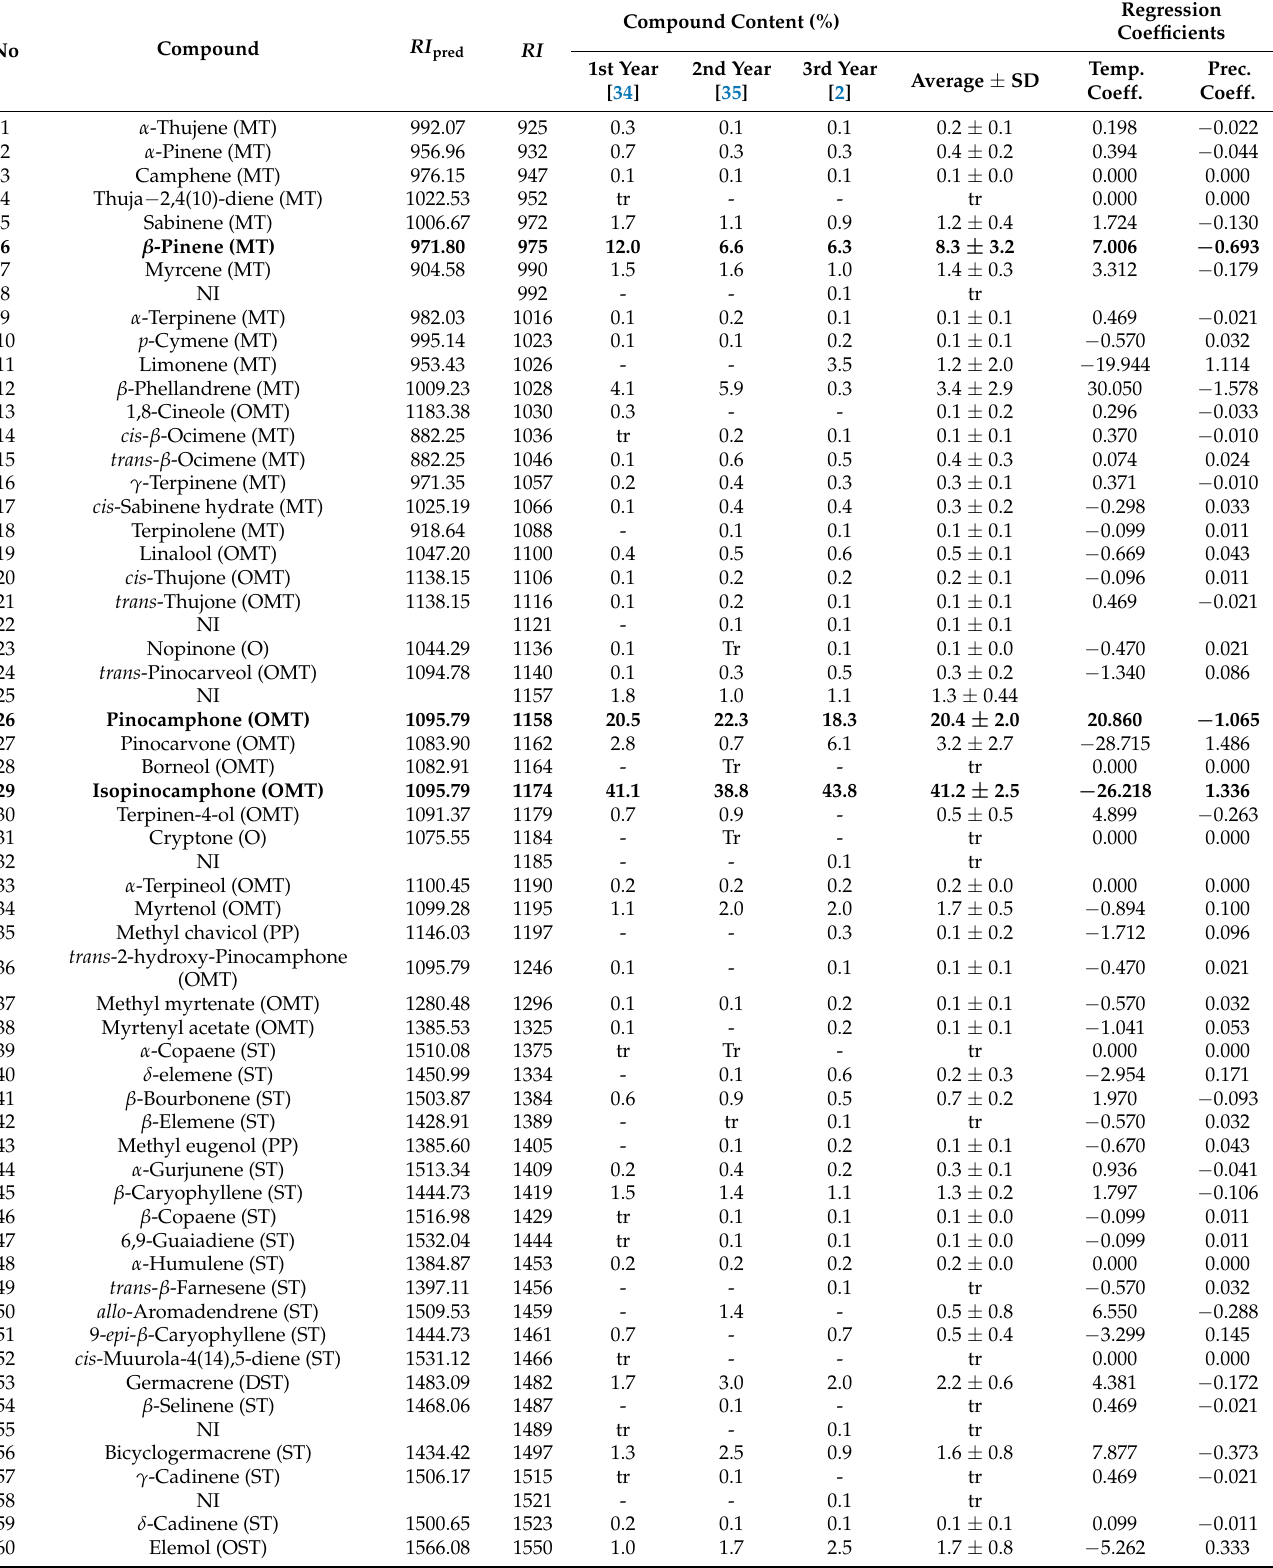
Table 2. H. officinalis essential oil composition during three growing years; temperature and precipitation regression coefficients in the linear model for compound content